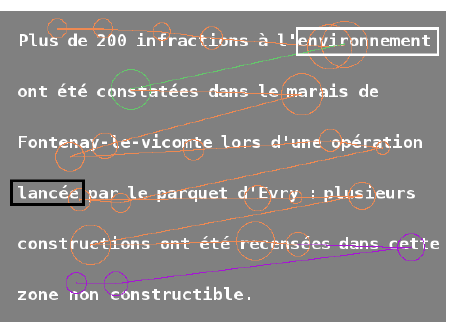
Figure 2. Scanpath of some MR text with phase restoration. Tar- get topic is “Nuclear waste”. Phase 1 (normal reading) is in or- ange, phase 2 (information search) in green and phase 4 (slow confirmation) in purple. Translation: “More than 200 violations to environment were recorded in the swamp next to Fontenay-le- vicomte during an operation launched by Evry’s prosecution ser- vice; several buildings were recorded within this non-buildable land.” The word framed in white (“environment”) is the closest to target topic, that framed in black (“launched”) is the farther- most to target topic.